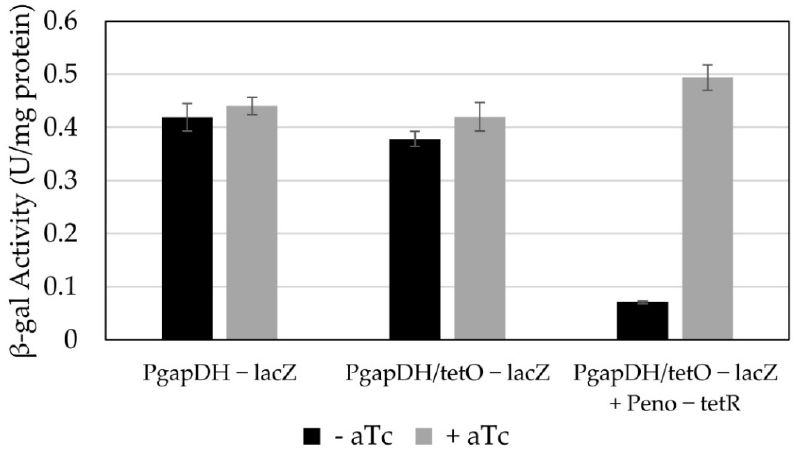
Figure 6. Anhydrotetracycline-inducible promoter construct plasmids and their associated β -gal activity in cultures with and without the addition of aTc (150 µ g L − 1 ). The values represent the average specific activity in technical triplicates for P gapDH — lacZ and P gapDH/ tetO — lacZ controls ( n = 3), and the average rate of ONP production of biological and technical triplicates of the P gapDH/ tetO — lacZ + P eno — tetR constructs ( n = 9). The error bars represent the standard deviation of the